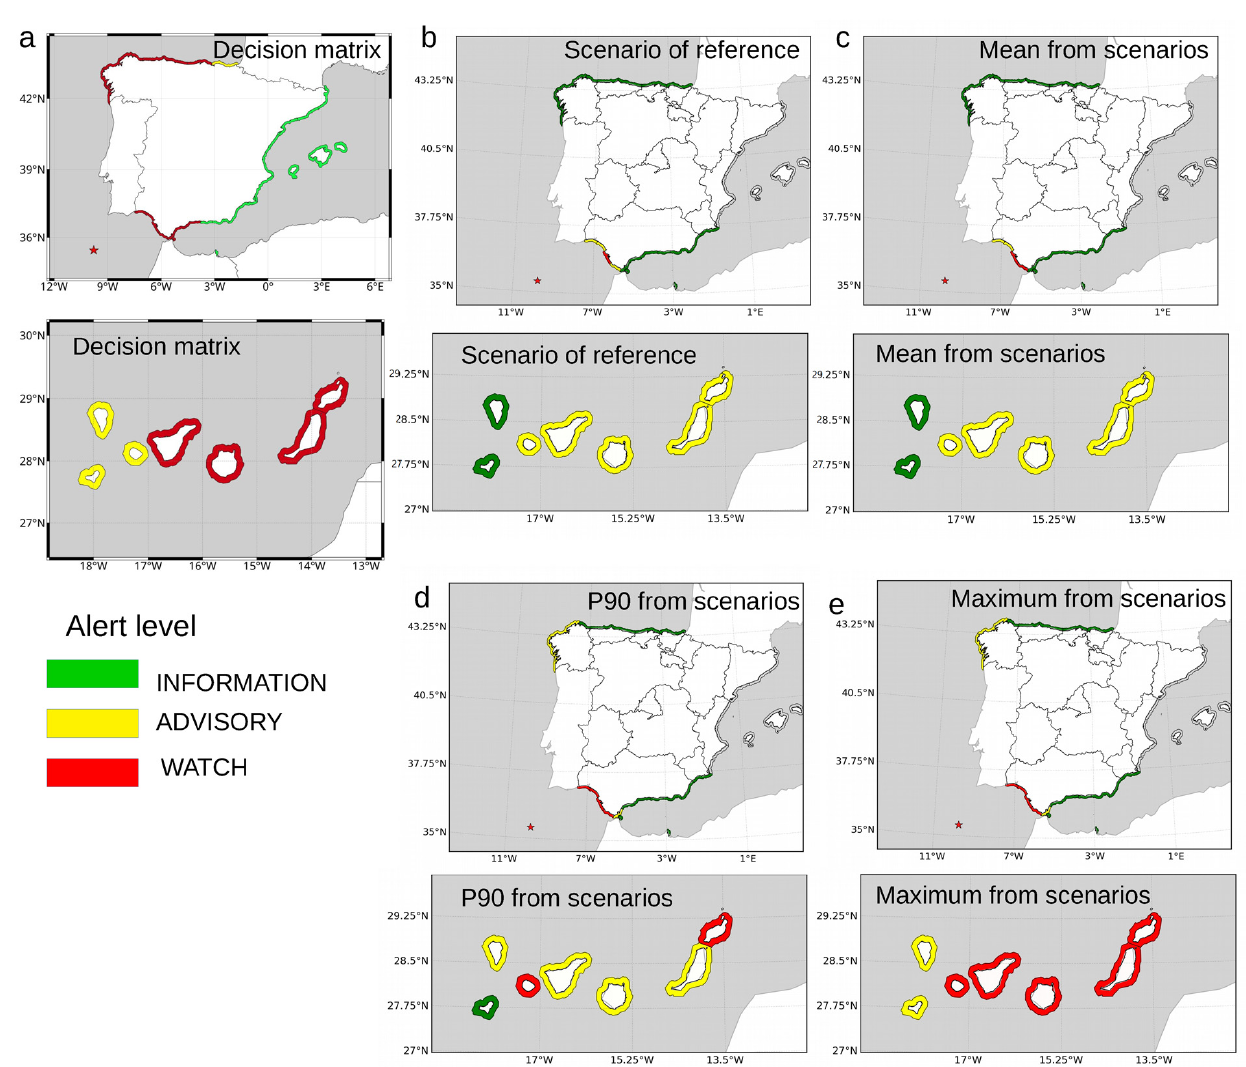
Figure 7. Tsunami warning maps obtained from the maximum tsunami height at close-to-the-coast FCPs computed with the ( a ) decision matrix, ( b ) scenario of reference, ( c ) mean, ( d ) 90th percentile, and ( e ) maximum of all 135 scenario results, computed at 1/2 arcmin domain resolution. Table 2. Comparison of operational parameters at the National Tsunami Warning System of Spain for tsunamis generated in the Gulf of Cadiz and at the ChEESE live demo.